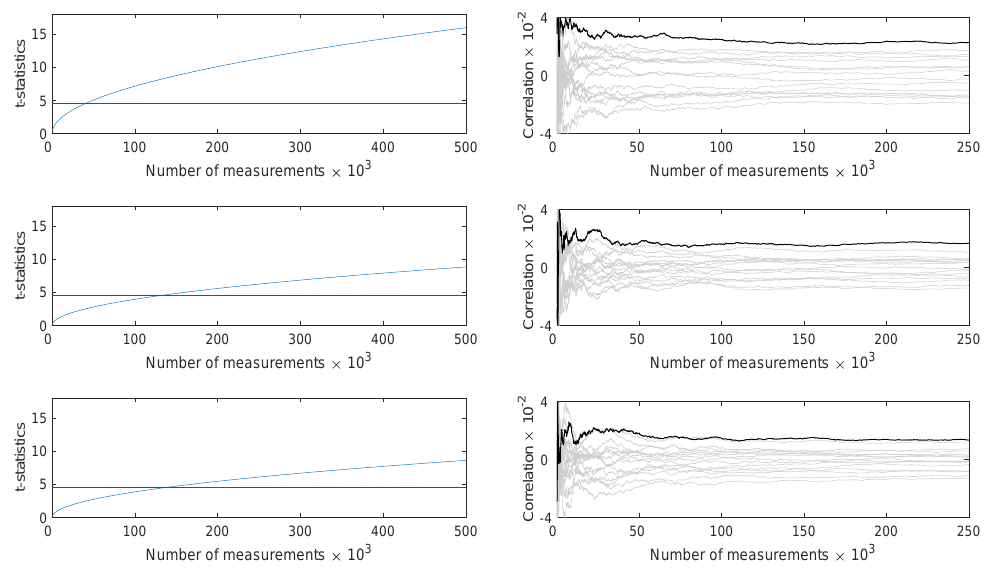
Figure 7: Non-specific t -test and CPA results on simulated leakage measurements from the 65 nm post-layout netlist of the PRESENT S-box after 0, 4 and 8 weeks of aging (top to bottom). The CPA targets a key nibble using the HW of the S-box